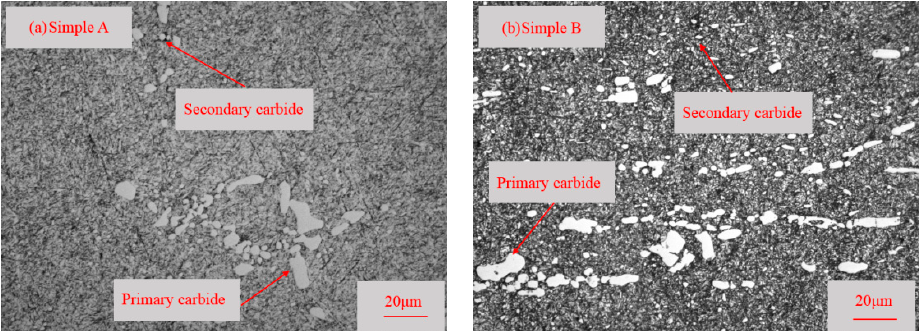
Figure 4. Metallographic observation of the microstructures of specimens: ( a ) sample A; ( b ) sample B.